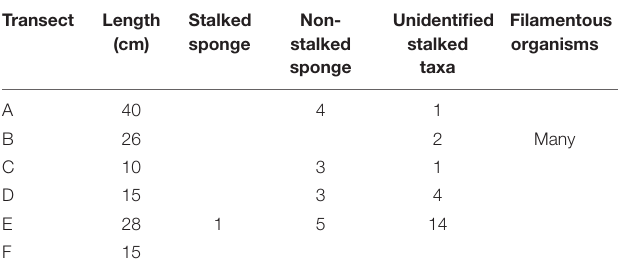
TABLE 2 | Counts of taxa observed on the boulder found at FSW2 (for location of transects refer to Figure 3 ).